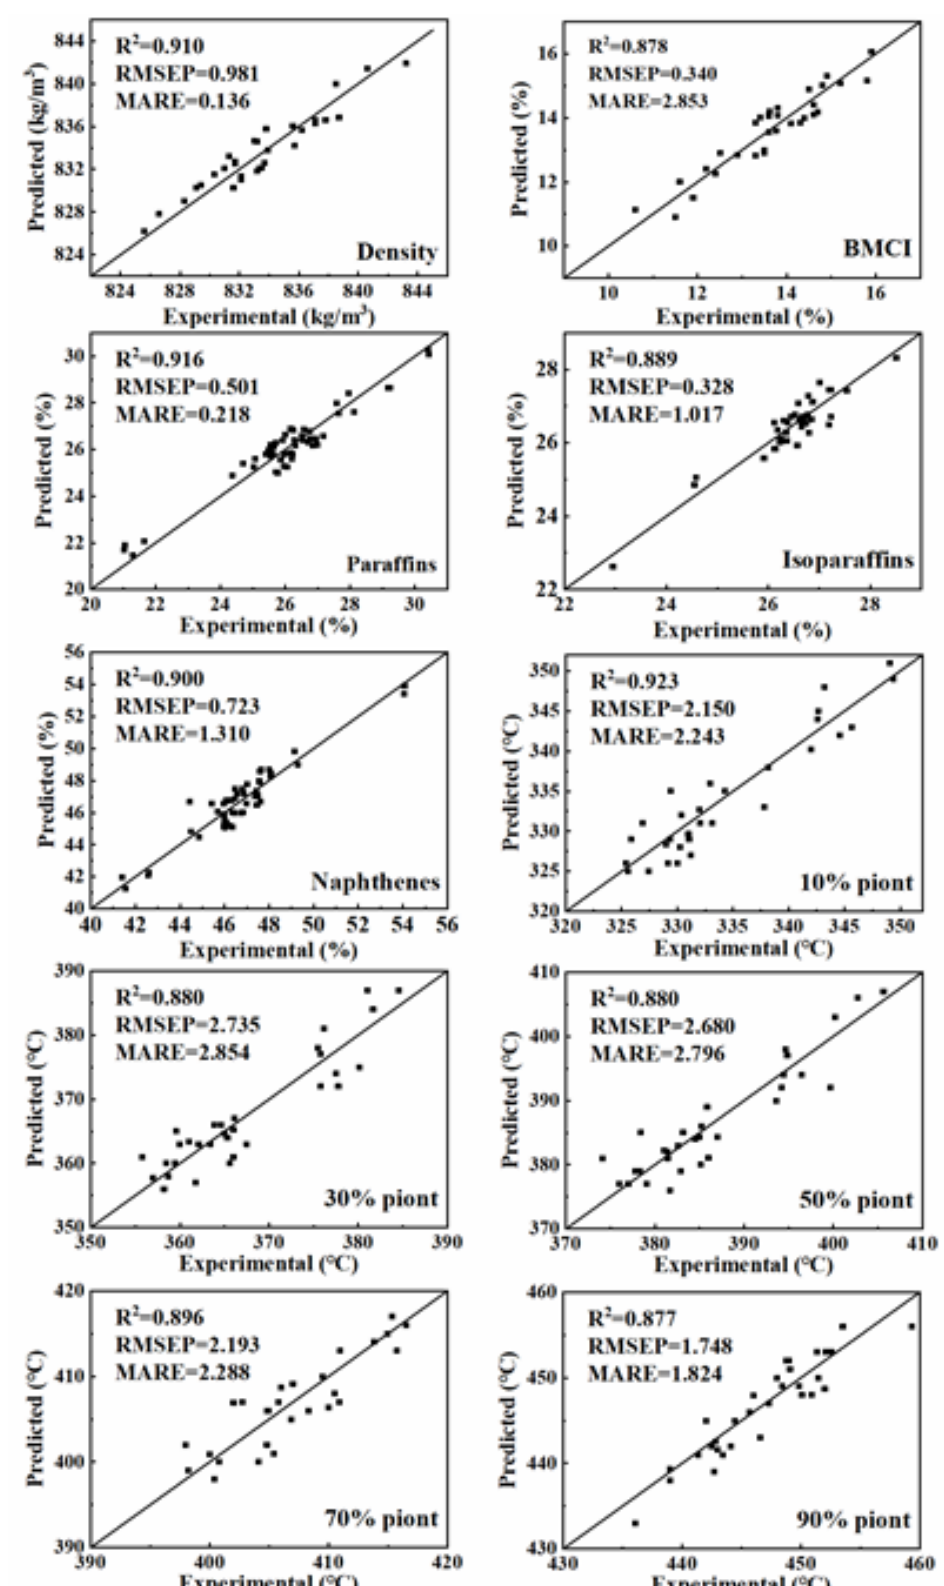
Figure 7. Estimation of the values of density, BMCI , paraffins, isoparaffins, naphthenes, 10% point, 30% point, 50% point, 70% point, and 90% point by the KPLS model according to the NIR spectra compared with the values determined by reference methods.